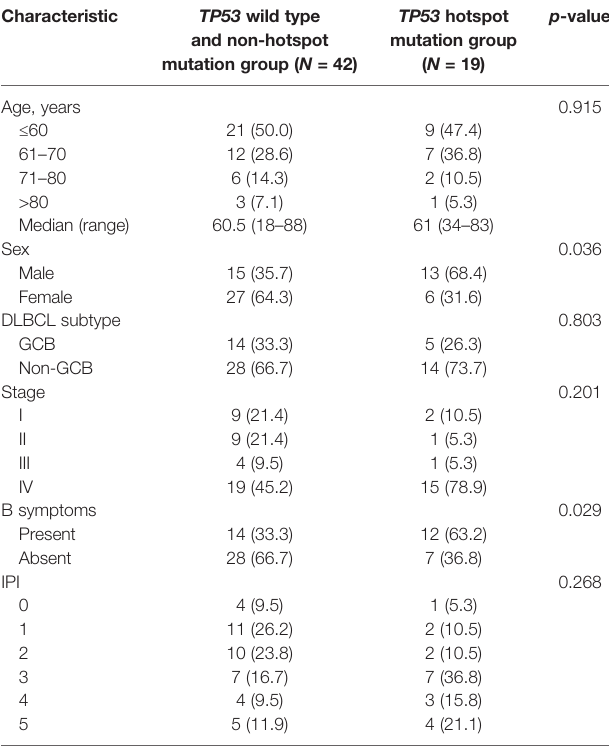
Values represent n (%) unless otherwise indicated. Differences between groupswere evaluated with themaximumlikelihood chi-squared test and Fisher ’ s exact test for categorical variables and the Mann – Whitney U test for continuous